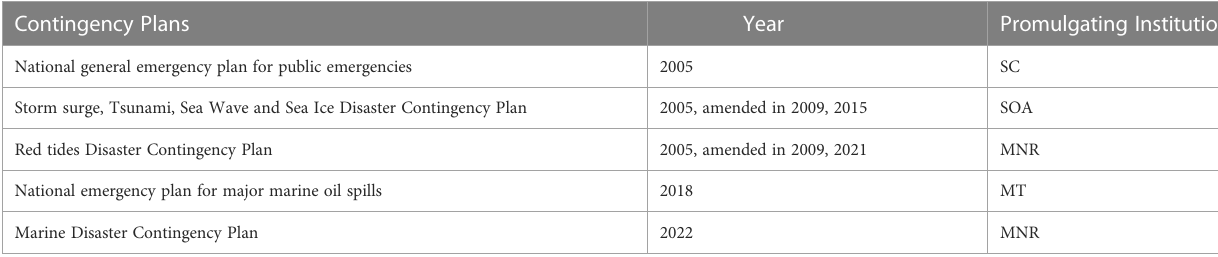
TABLE 3 Contingency Plans issued by the Chinese government. Contingency